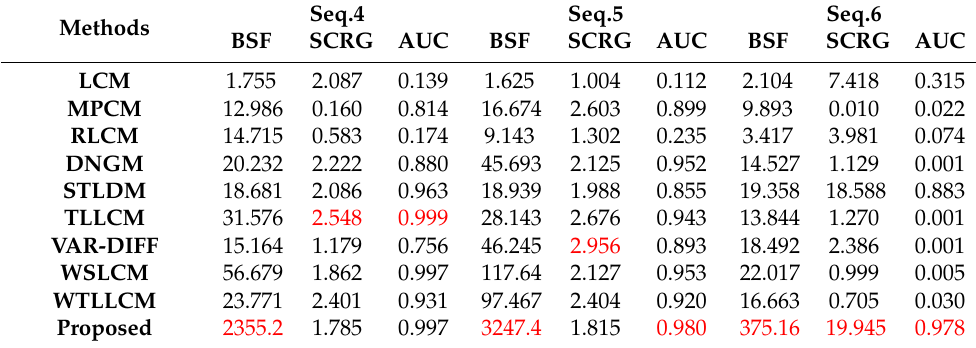
Table 4. Measurements for ten detection